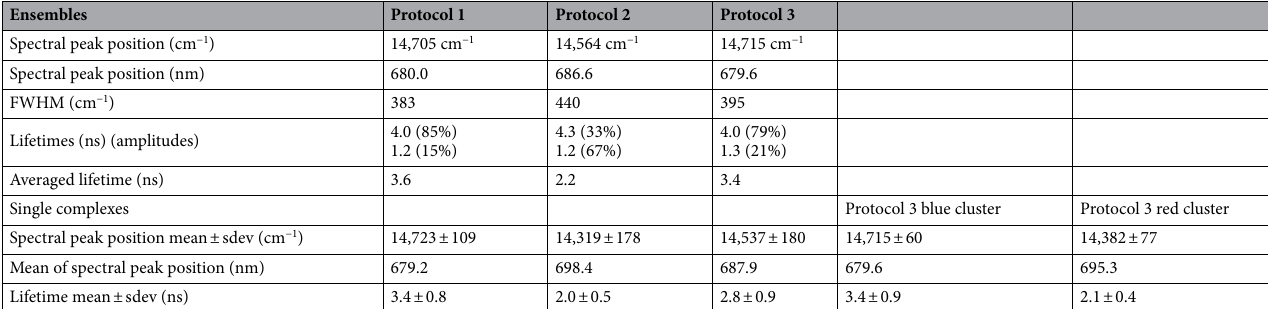
Table 1. Summary of the spectroscopic results from SCP complexes as a function of the sample preparation conditions. For the ensemble data the spectral peak positions and the widths (FWHM) of the emission spectra are provided. For the single complex data, the means and standard deviations of the respective distributions are given. The excitation intensity at 561 nm was always 525 W/cm 2 .